Question: Identify the chart type used in this figure.
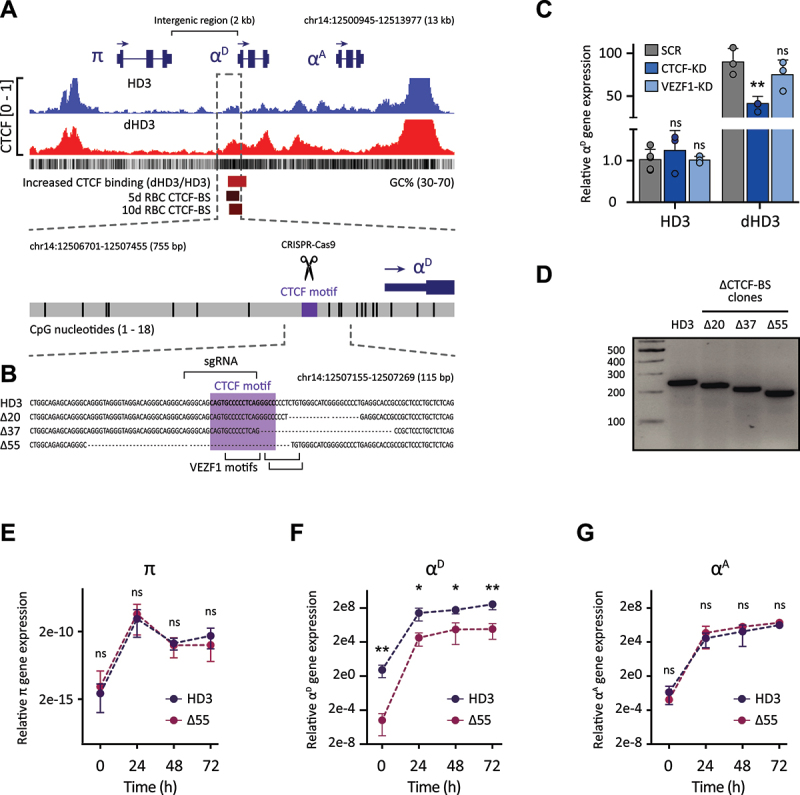
Answer: bar